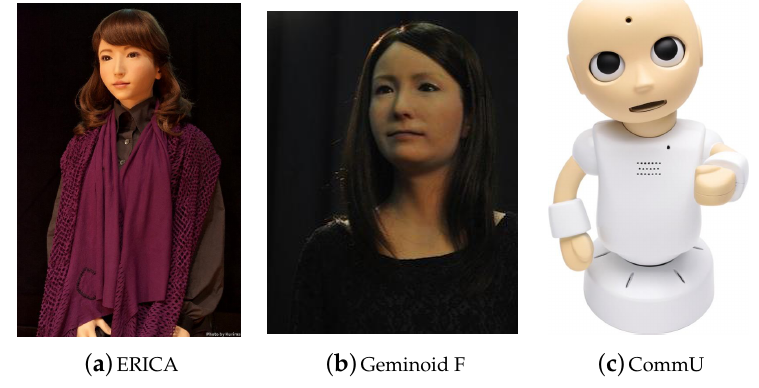
Figure 1. Android and robot